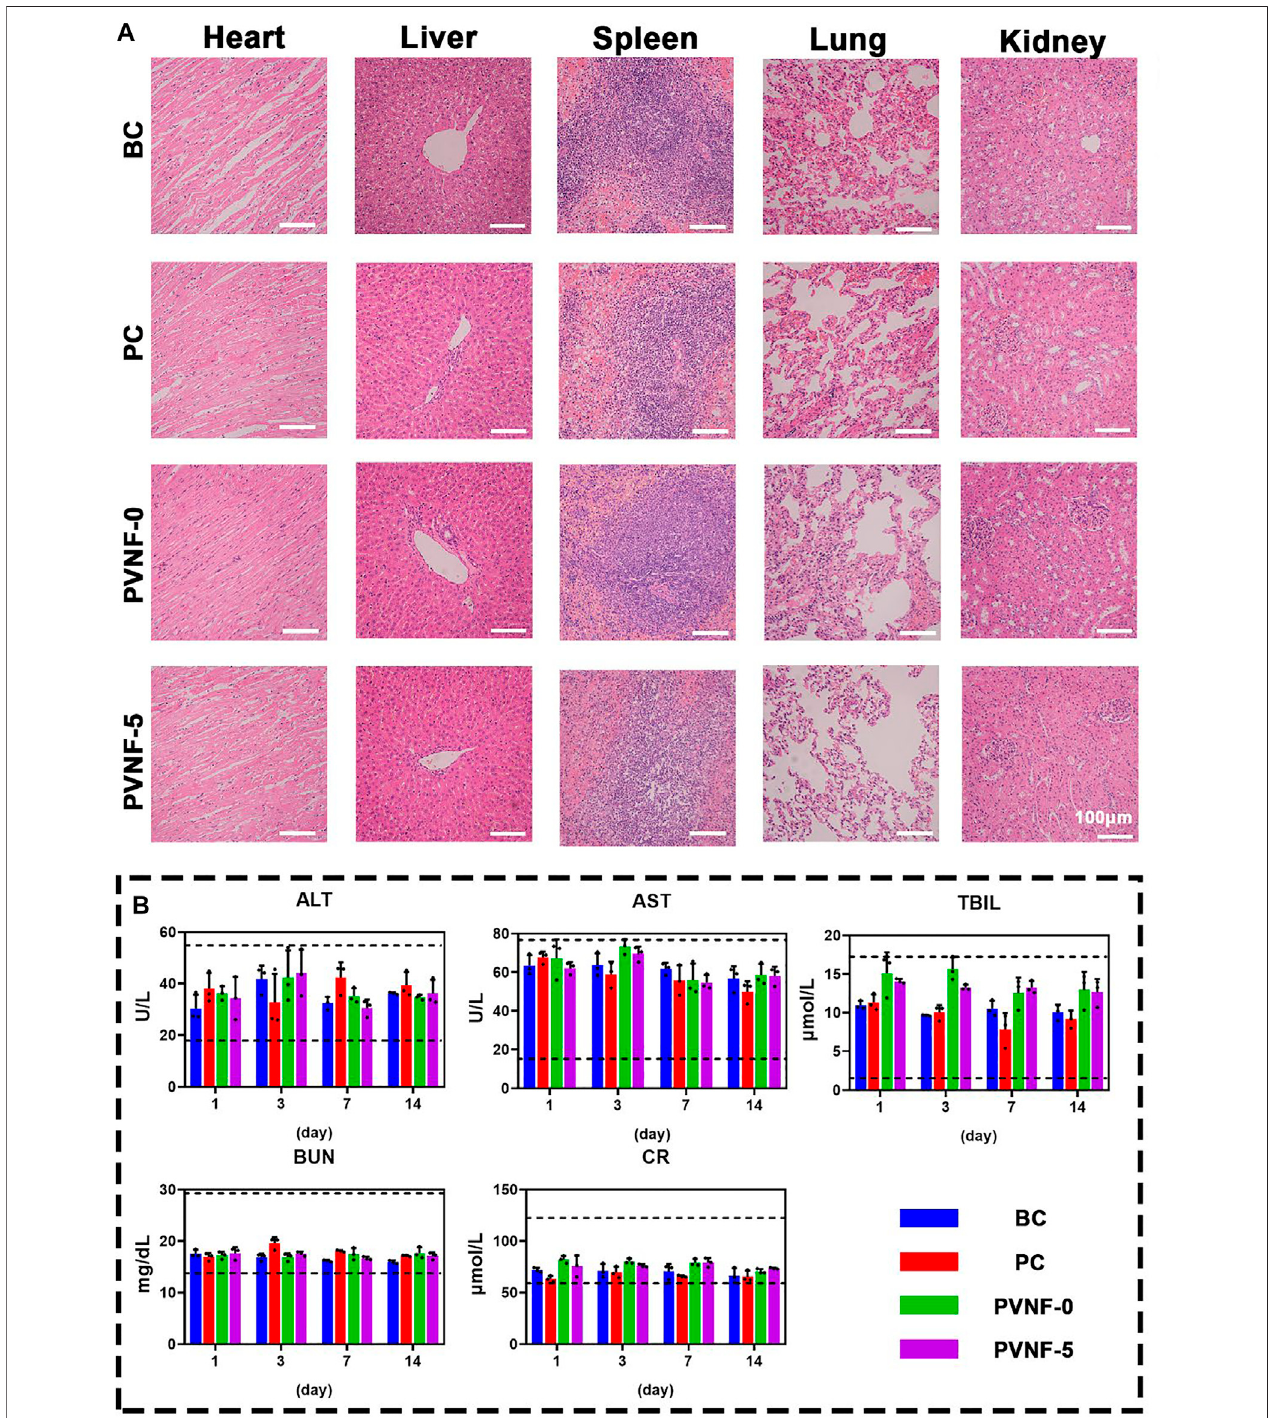
FIGURE 8 | (A) Histological evaluations of the toxicity and side effects of the airway stent in the BC, PC, PVNF-0, and PVNF-5 groups, respectively. HE staining of the heart, liver, spleen, lungs, and kidneys was performed. (B) Levels of alanine aminotransferase (ALT), aspartate aminotransferase (AST), total bilirubin (TBIL), blood urea nitrogen (BUN), and serum creatinine (Cr) in four groups were detected after stenting at 1, 3, 7, and 14 days ( N (cid:1) 3); Scale bar: 100 µm.